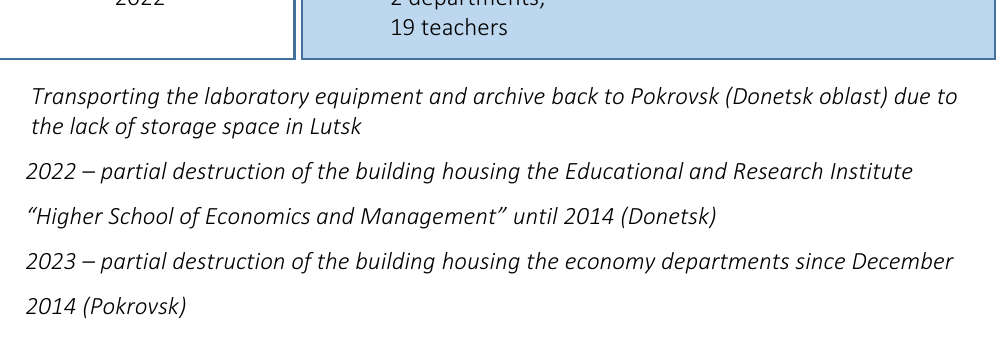
Figure 1. Transformation of the Educational and Research Institute of Donetsk National